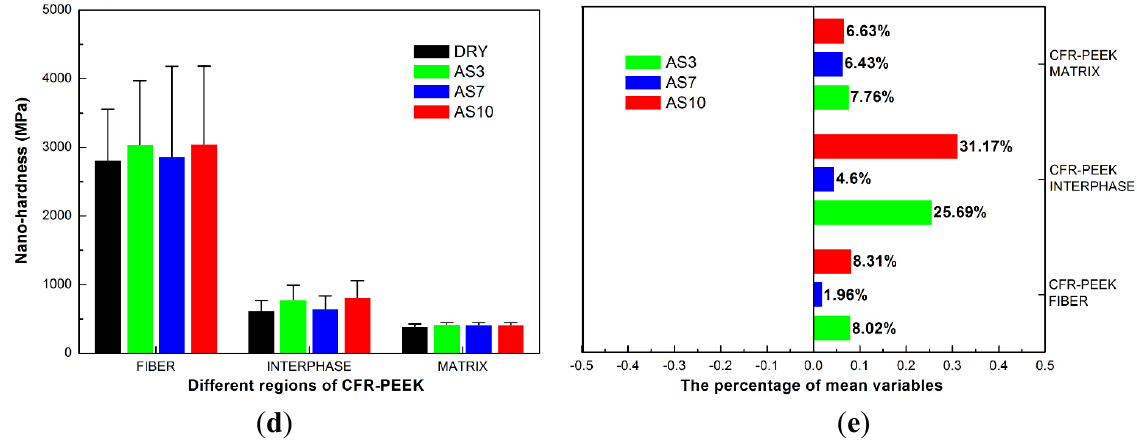
Figure 4. ( a ) Schematic of different load-displacement curves represents different regions of CFR-PEEK. The distinct permanent set profile can be seen in the matrix region after a 6000- μ N indentation (left SPM figure). When indentation was performed on a carbon fiber, almost no permanent set was observed. The region pointed by the black thin arrow mark is the position where indentation was performed (right SPM figure). ( b , c ) Reduced elastic moduli (GPa) and percentage of mean variables of different regions of CFR-PEEK. The bars represent standard deviations. ( d , e ) Nanohardness (MPa) and percentage of mean variables of different regions of CFR-PEEK. The bars represent standard deviations. In the ( b ) and ( d ), the negative number on the X axis represents a decrease and positive number represents an